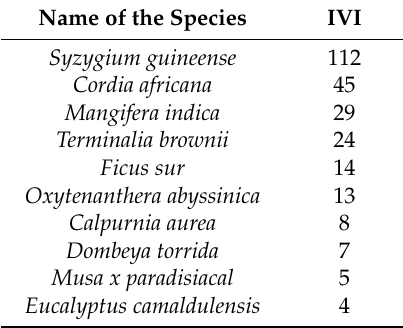
Table 5. Importance value index (IVI) ranking of the top 10 woody and herbaceous perennial species in parkland agroforestry systems of Assosa district, western